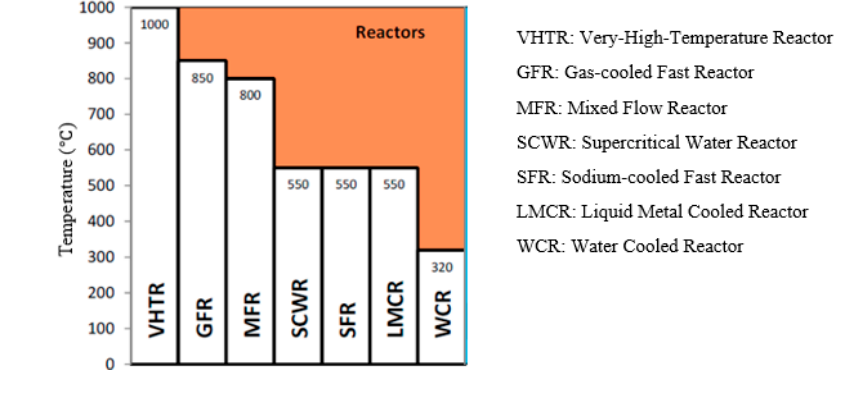
Figure 5. The range of applicability for nuclear reactors [4].